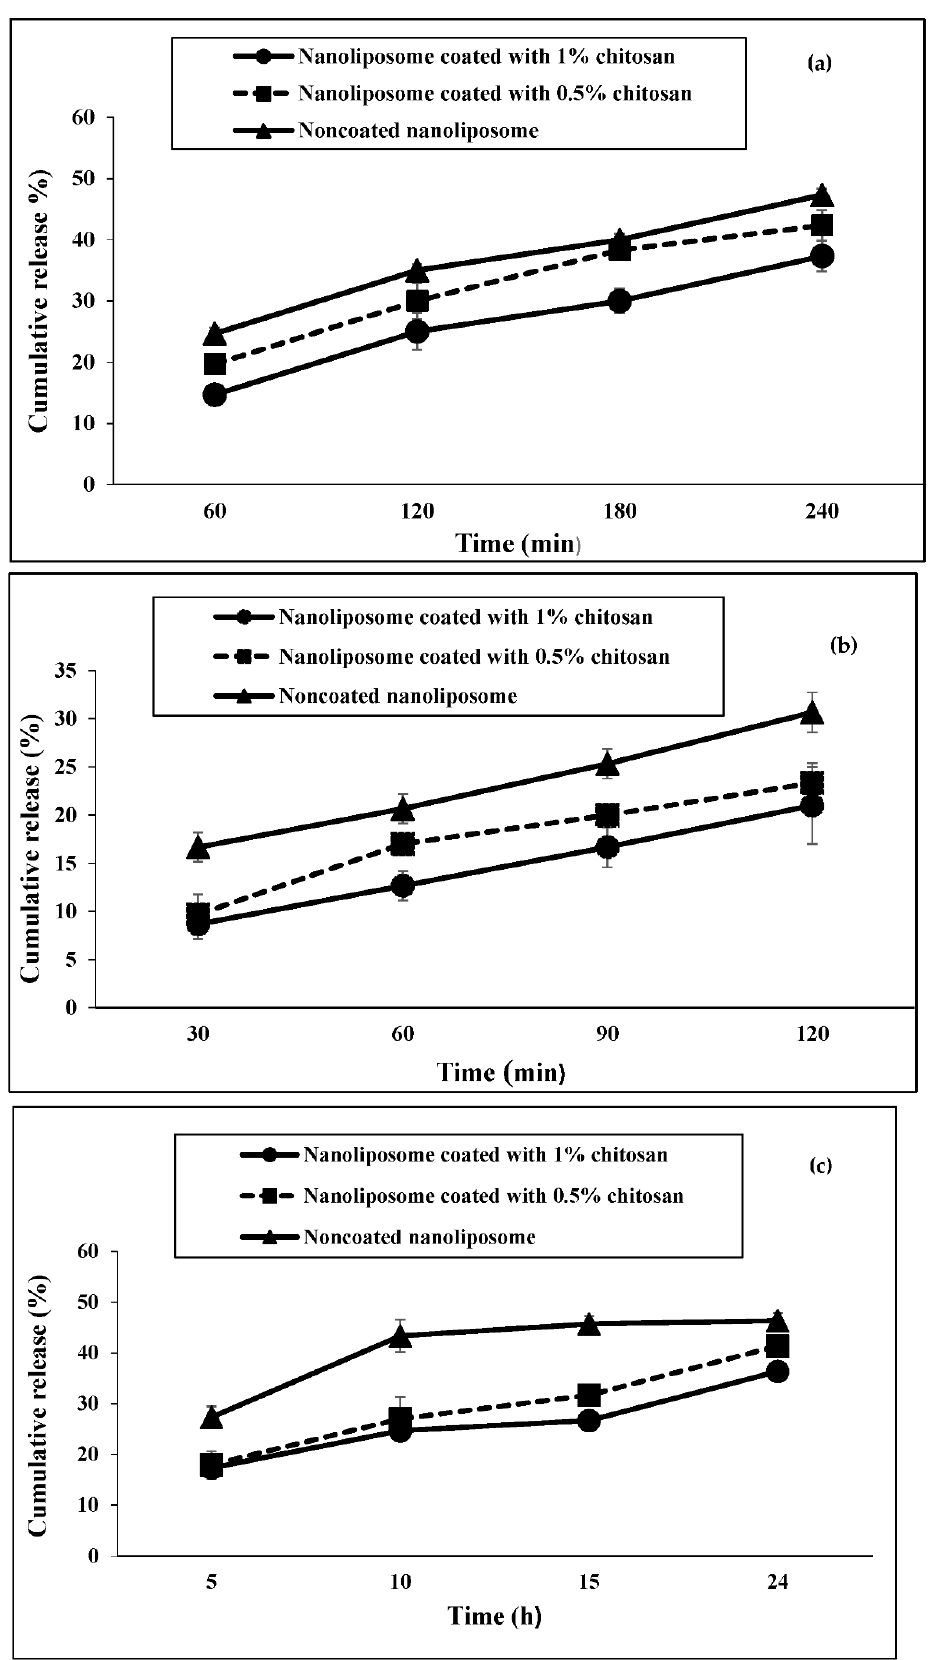
Figure 5. Release of nanoliposome peptides in different simulated media over different periods, ( a ) intestine, ( b ) gastric, ( c ) PBS.